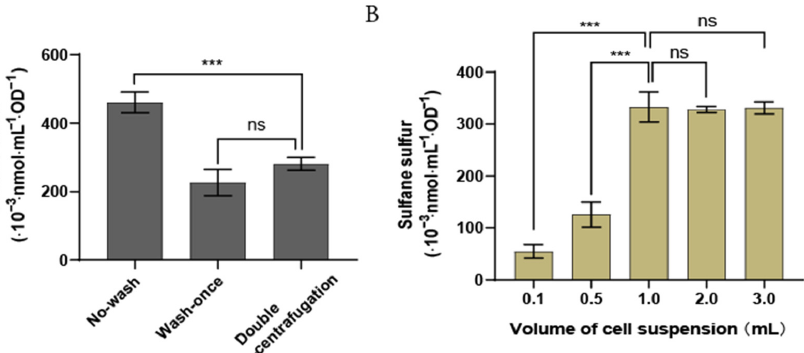
Figure 5. Effects of different treatment conditions on iSS content in E. coli cells. ( A ) The harvested cells were treated in three different ways. No-wash, the harvested cells directly proceeded for SdSS analysis without washing; wash-once, the harvested cells were washed once with 50 mM Tris-HCl (pH = 7.4); double-centrifugation, the cell pellets were re-centrifuged and the residual supernatant was removed. ( B ) Different volumes of cell suspension at OD 600 of 1.0 were harvested and analyzed by using the optimized method. Three parallel experiments were performed to obtain the averages and standard deviations (n = 3). The one-way ANOVA method was used to calculate the p -values (ns, p ≥ 0.05; ***, p < 0.001).